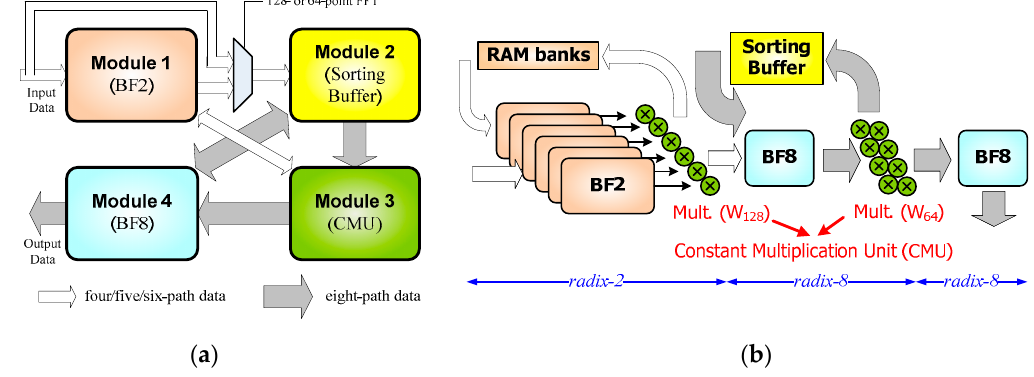
Figure 6. ( a ) Block diagram of proposed MRM 2 DF FFT kernel; ( b ) module-associated operations.